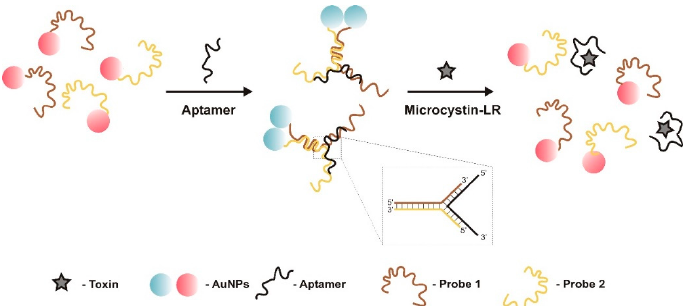
dimer [58]. When microcystin-LR is added, the aptamers leave the DNA probes and link to the toxin, changing the structure. The pre-formed AuNP dimers disassemble to monomers and, solution color changing from blue to red.